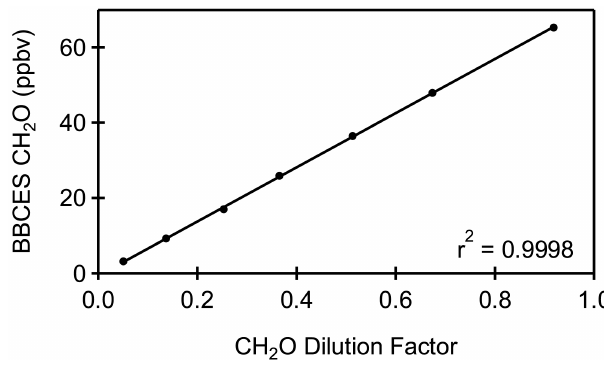
Figure 6. Correlation plot comparing CH 2 O measurements from the BBCEAS with the dilution scaling during 1min standard ad- ditions. The absolute CH 2 O concentration is not well known, so the slope is not calculated. The r 2 value is 0.9998 and intercept is − 0 . 6 ± 0 . 2ppbv.